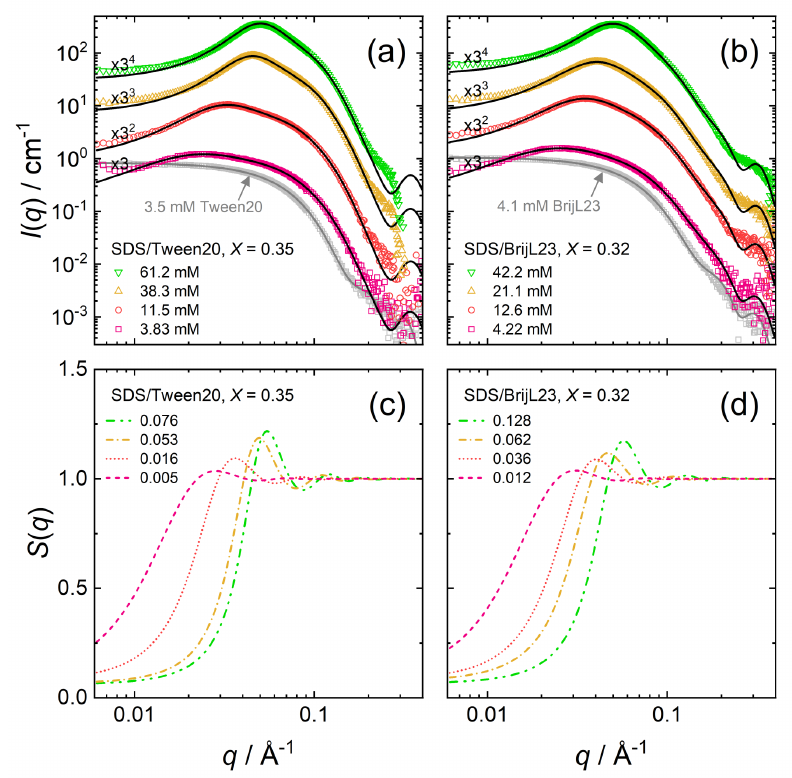
Figure 5. SANS data for mixed micellar dispersions at various concentrations: ( a ) SDS/Tween20, ( b ) SDS/BrijL23. Symbols are experimental scattering data. The black solid lines are model fits to the data by Equation (1). Data sets are scaled by the factors in black for clarity. Extracted structure factors S ( q ) from the model fits: ( c ) SDS/Tween20, ( d ) SDS/BrijL23. Data are given for different volume fractions φ